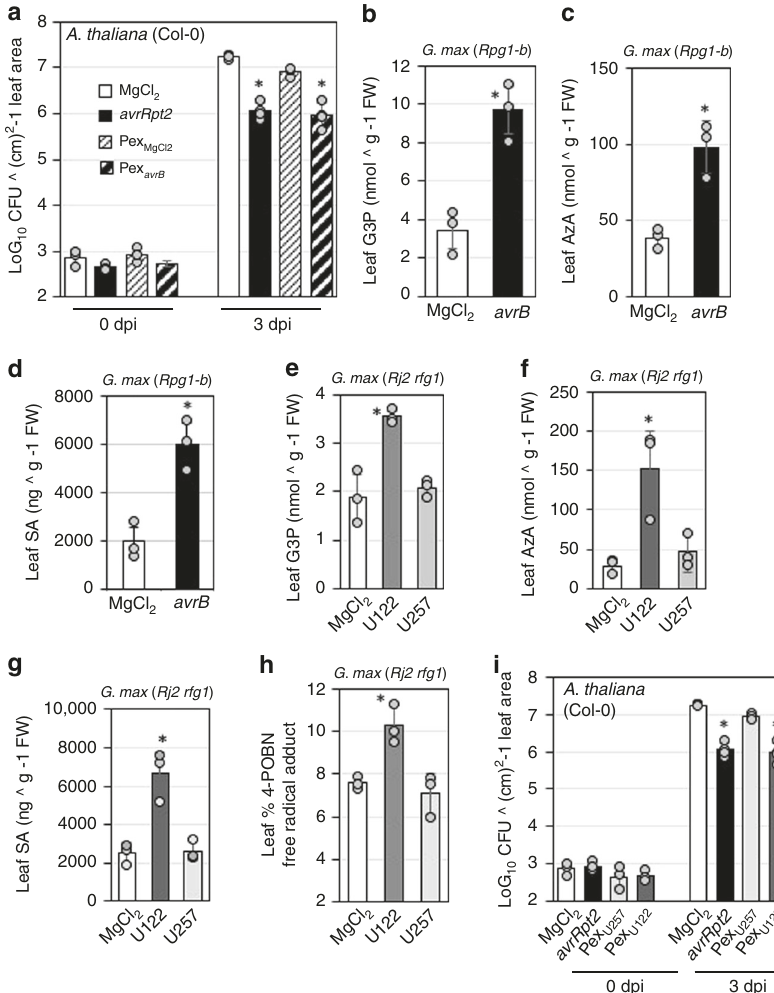
Fig. 3 Incompatible rhizobia induce the accumulation of SAR-associated metabolites. a Bacterial counts of Pst DC3000 in Arabidopsis thaliana (Col-0). LOG 10 values of colony forming units (CFU) ^ cm 2 -1 leaf area from infected leaves at 0 and 4 dpi are presented. Error bars indicate standard deviation ( n = 4). Asterisks denote data signi fi cantly different from MgCl 2 , Student ’ s t -test, P < 0.001. Plants were pretreated with buffer (MgCl 2 ), Pst avrRpt2 , or petiole exudate from MgCl 2 -in fi ltrated (Pex MgCl2 ) or Psg avrB -infected (Pex avrB ) soybean plants. b – d SAR-associated metabolite levels in MgCl 2 or avrB infected leaves of Rpg1-b soybean ( G. max ) plants at 24h. b Glycerol-3-phosphate (G3P), c azelaic acid (AzA), and d salicylic acid (SA) levels. Error bars indicate standard deviation ( n = 5). Asterisks denote data signi fi cantly different from MgCl 2 , Student ’ s t -test, P < 0.0001. e – h SAR-associated metabolite levels in leaves of MgCl 2 , U122 or U257 inoculated Rj2 rfg1 soybean ( G. max ) plants. e G3P at 24 h, f AzA at 24 h, g total SA at 48 h, h electron spin resonance (ESR) spectrometry showing relative levels of free radicals at 24 h post rhizobia inoculation. Error bars indicate SD ( n = 5). Asterisks denote signi fi cant differences from MgCl 2 , Student ’ s t -test, P < 0.005. i Bacterial counts of Pst DC3000 in A. thaliana (Col-0). LOG 10 values of CFU ^ cm 2 -1 leaf area from infected leaves at 0 and 3 dpi are presented. Error bars indicate standard deviation ( n = 4). Asterisks denote data signi fi cantly different from MgCl 2 , Student ’ s t -test, P < 0.001. Plants were pretreated with MgCl 2 , Pst avrRpt2 , or petiole exudate from U122 2 (Pex U122 ) or U257 (Pex U257 ) inoculated soybean plants. Results are representative of three independent